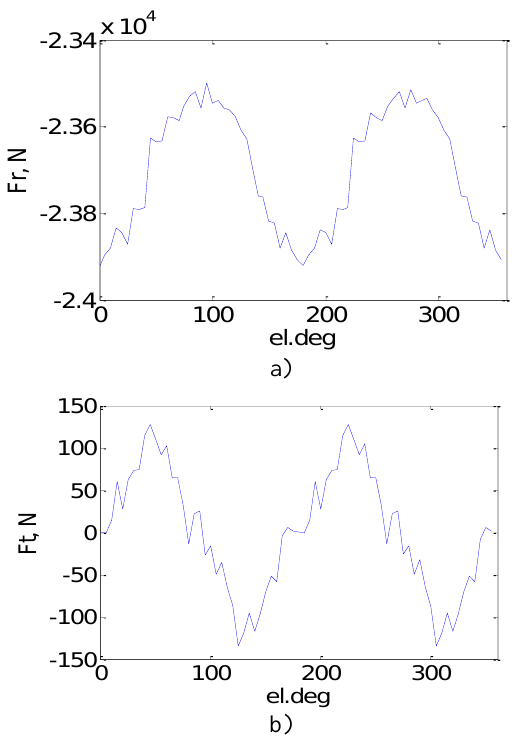
Fig. 7. Forces acting on the coil section: a) force in the radial direction; b) force in the tangential